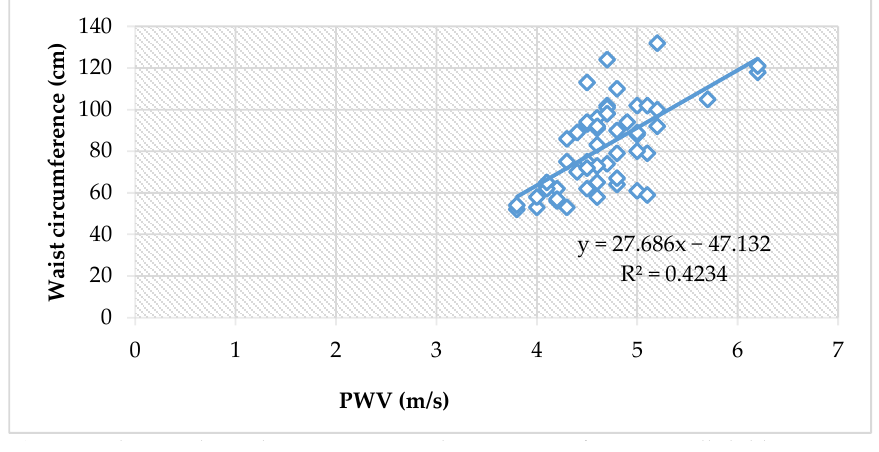
Figure 2. The correlation between PWV and waist circumference, in all children (Spearman’s ρ = 0.62, p < 0.0001).